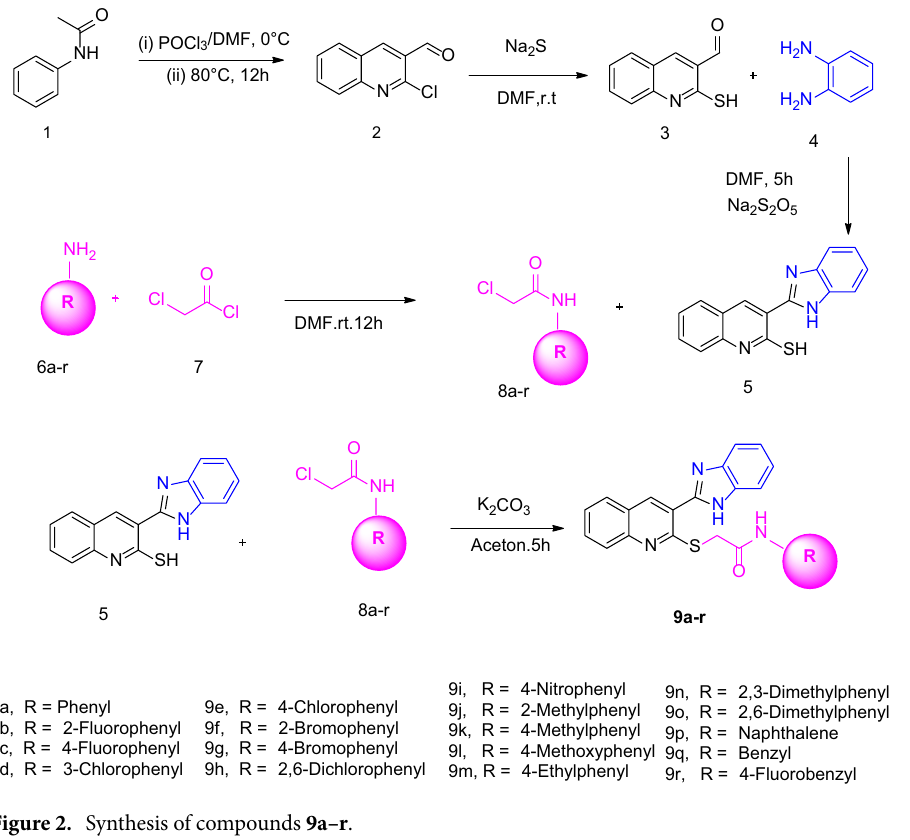
Figure 2. Synthesis of compounds 9a–r